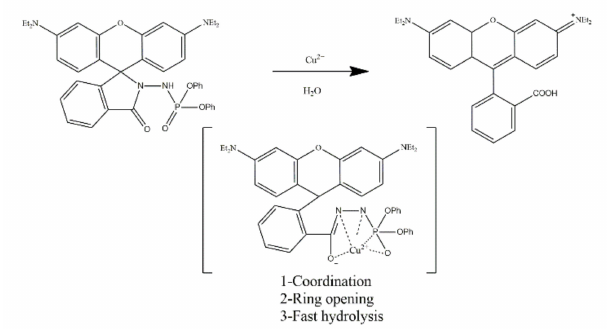
Figure 16. The proposed detecting mechanism of RhP (Table 1, No. 21) [52]. Wang Y., et al. synthesized a naked-eye and fluorescent chemosensor, by introducing pyrazinyl hydrazine in rhodamine B, for Cu 2+ detection (Table 1, No. 22) [53]. The sensor color changed from colorless to amaranth after Cu 2+ addition. The proposed response mechanism of the prepared sensor (Figure 17) was extrapolated through the results of mass spectra, fluorescence spectra, and theoretical calculations.